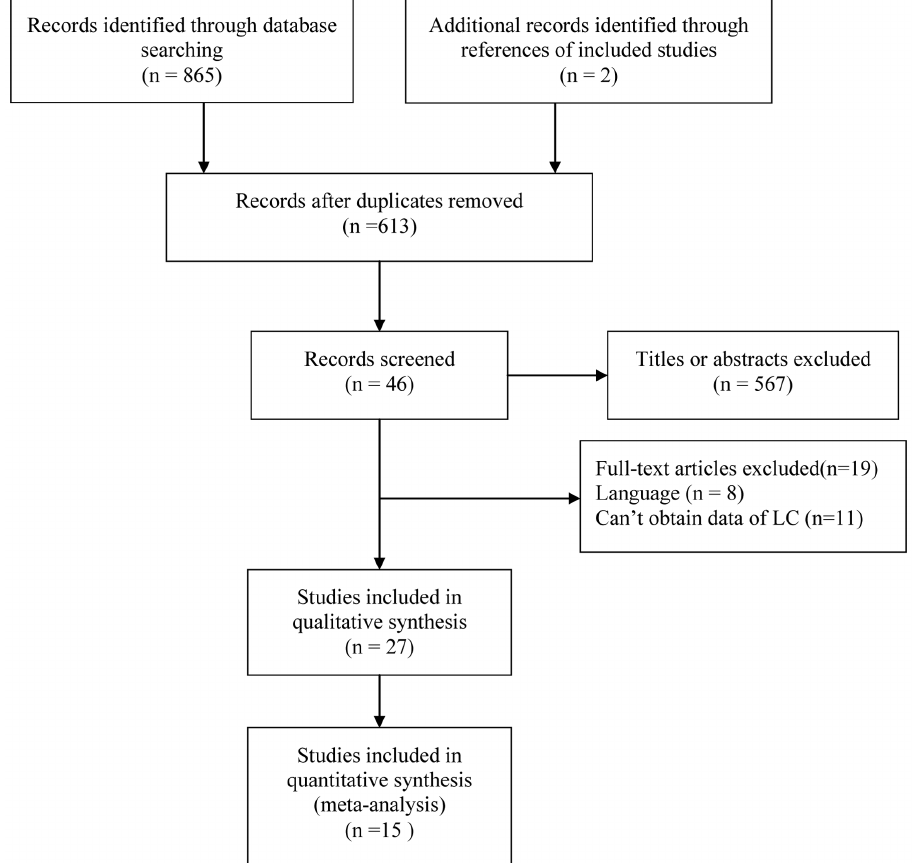
Figure 1. Flow chart from the identification of studies. LC, leptin concentration.